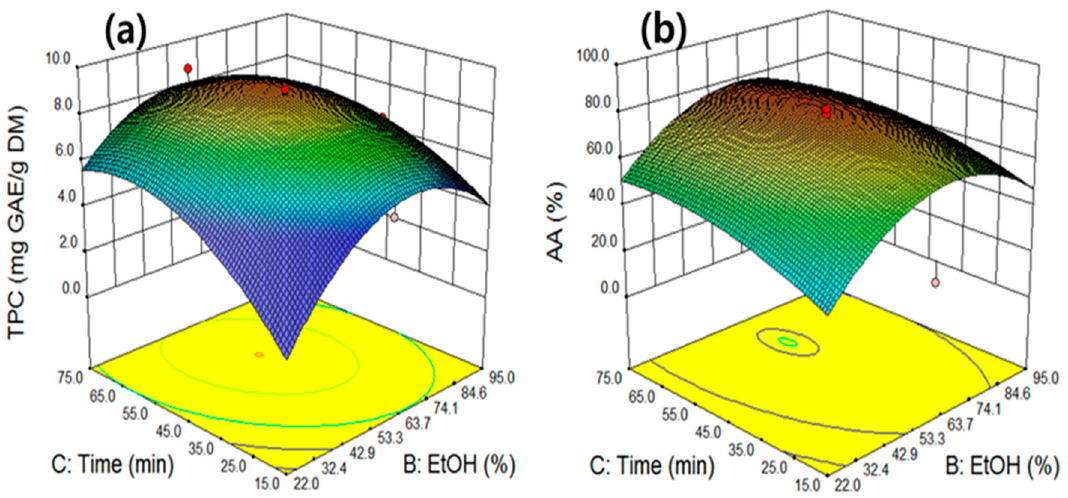
Figure 5. The interactive effect of ethanol concentration and time on total phenolic compounds ( a ) and antioxidant activity ( b ) at constant temperature 70 °C and power 500 W.